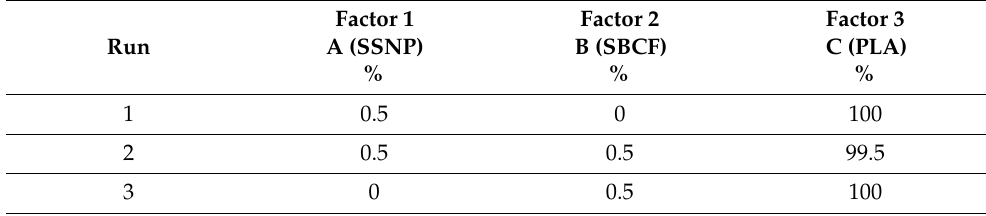
Table 1. Investigational runs designed for bioplastic films using the Box-Behnken